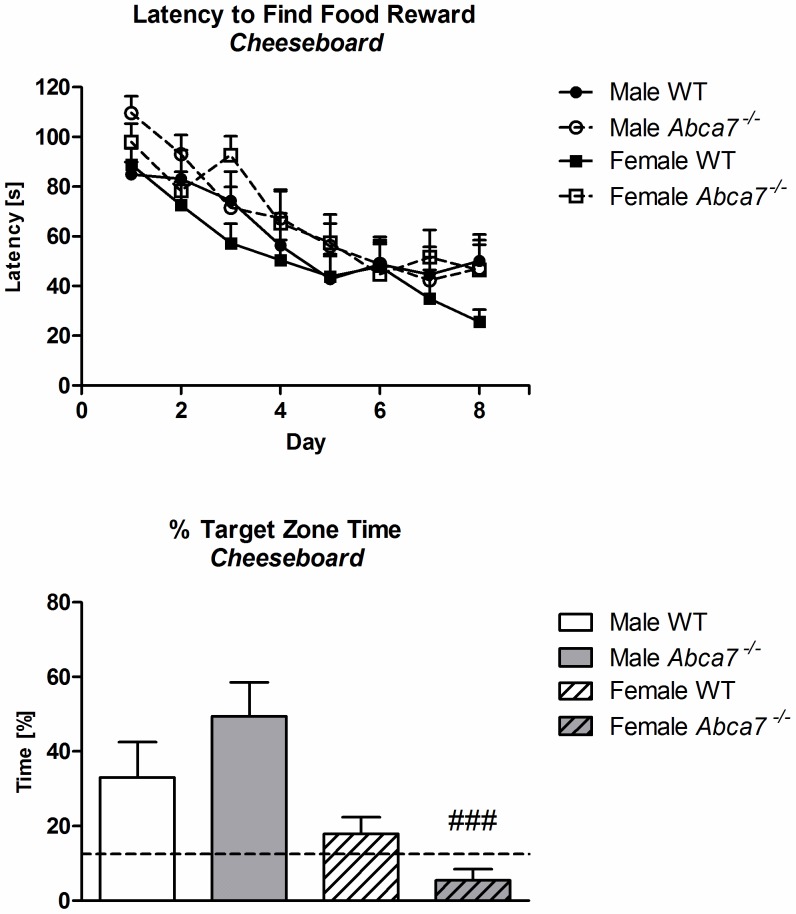
A+B Cheeseboard: A) Mean latency (averaged across three trials per day) to find the food reward [s] and B) percentage time [%] spent in the target zone during the probe trial (% target zone time).Time spent in the zone according to chance ( = 12.5%) is marked with a dotted line. There was a strong trend for an interaction of ‘sex’ with ‘genotype’ interaction in the probe trial (p = .05). Significant one-way ANOVA effects of females versus males of the corresponding genotype are indicated by ‘#’ (###
p<.001).